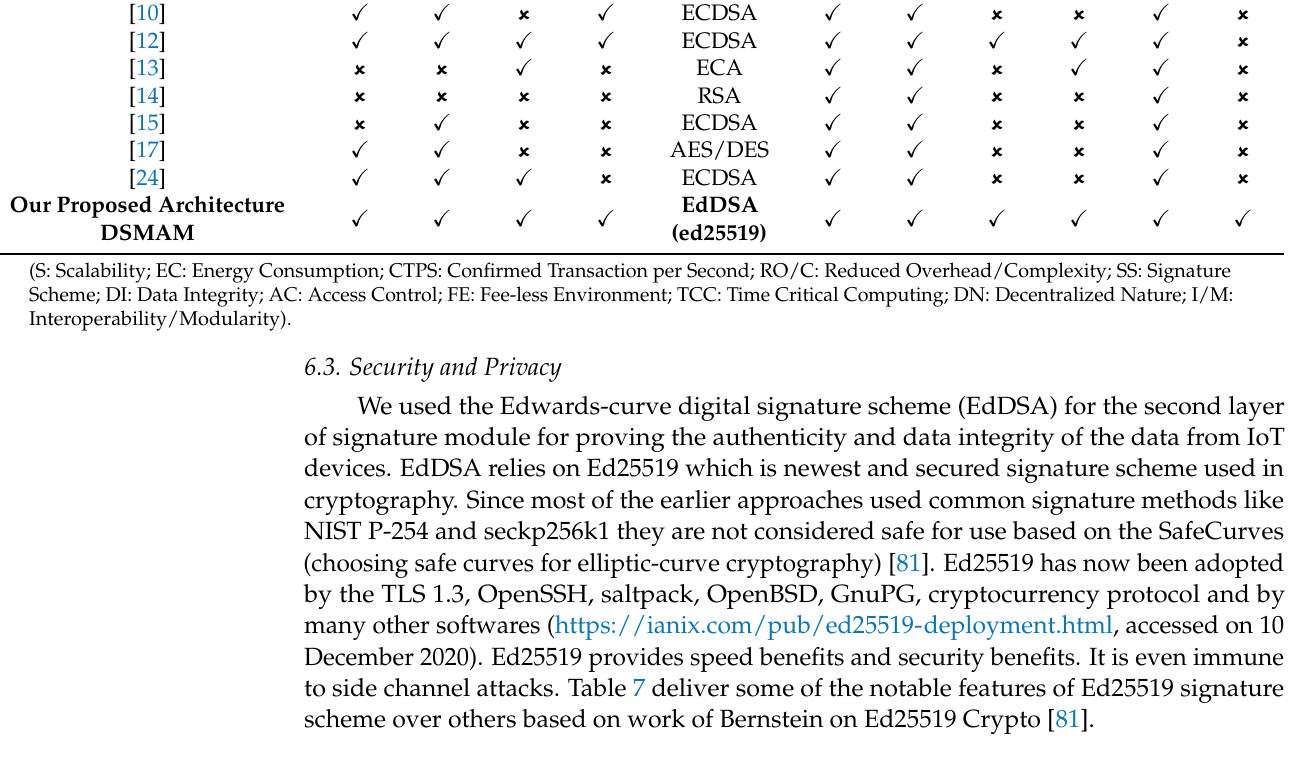
Table 6. Performance comparison based on defined parameters.